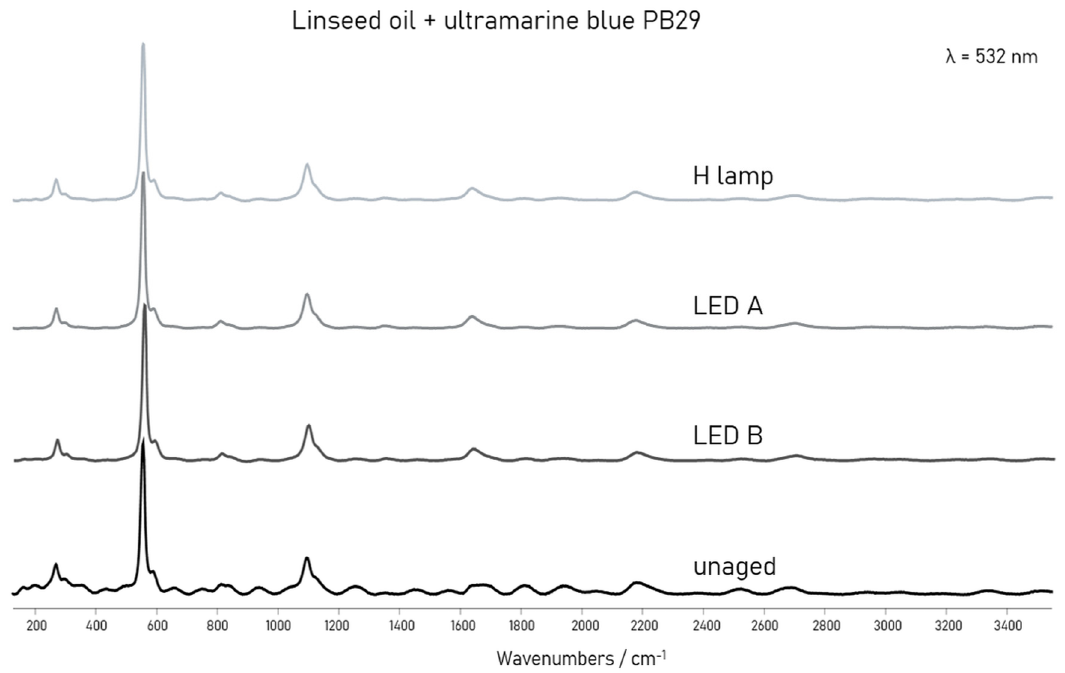
Figure 6. µ -Raman spectra of linseed oil with the ultramarine blue PB29 pigment before and after 5000 h of light ageing (LED A: 420 nm, LED B: 460 nm, and H lamp: halogen